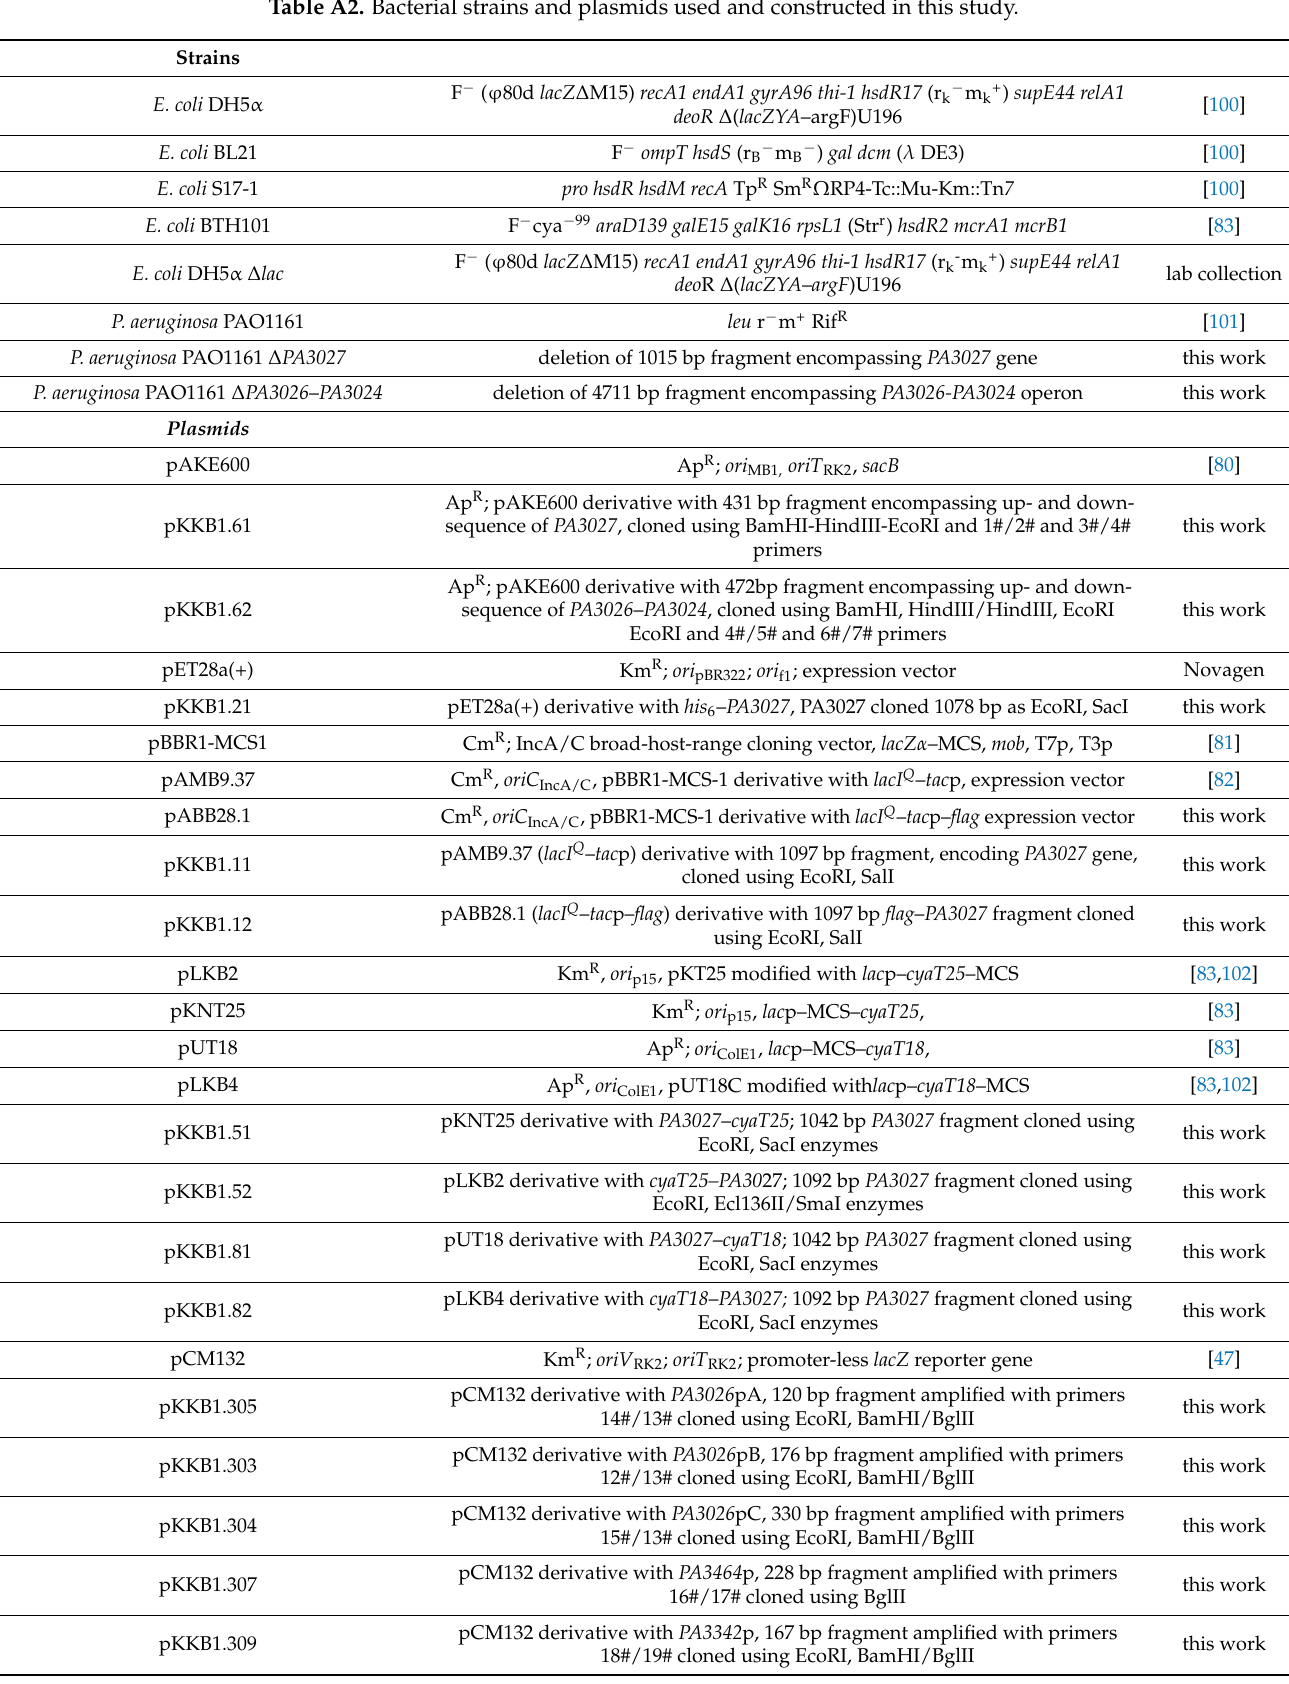
Table A2. Bacterial strains and plasmids used and constructed in this